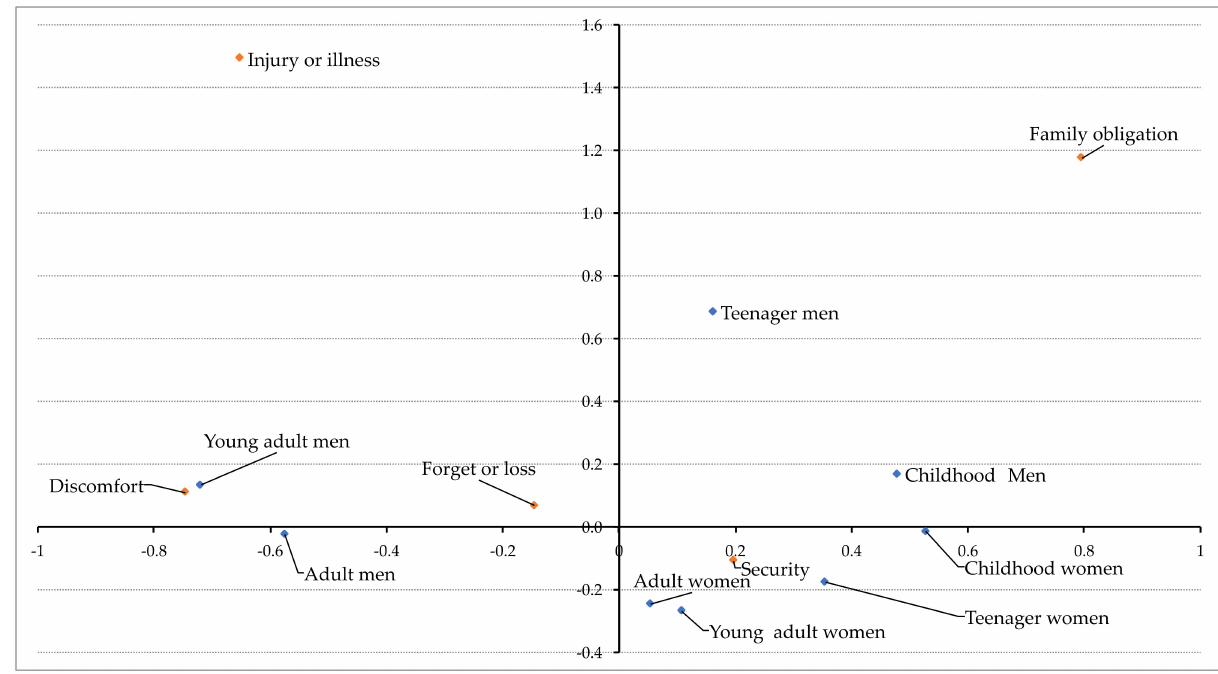
Figure 1. Correspondence analysis between stage development, sex, and reason to use/not use protective